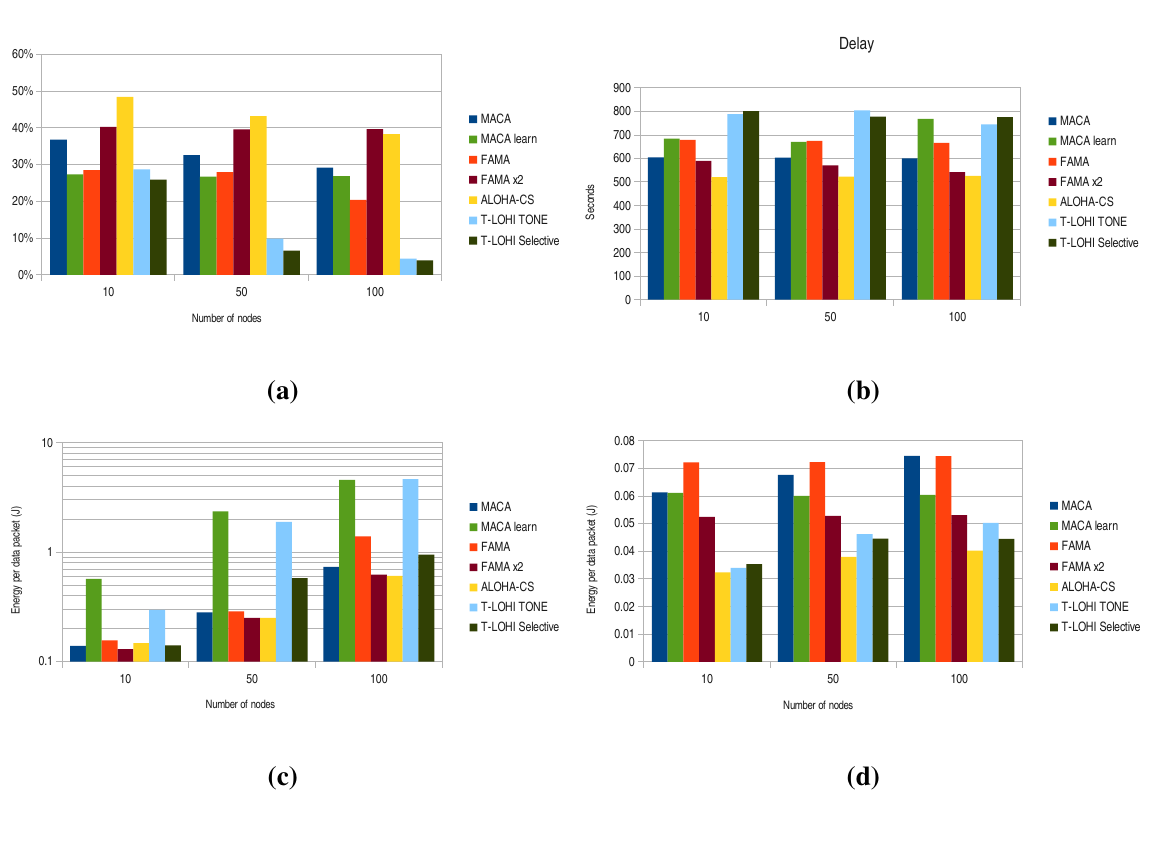
Figure 10. Results without acknowledgment. ( a ) Normalized received packets; ( b ) delay; ( c ) energy per data packet—node; ( d ) Energy per data